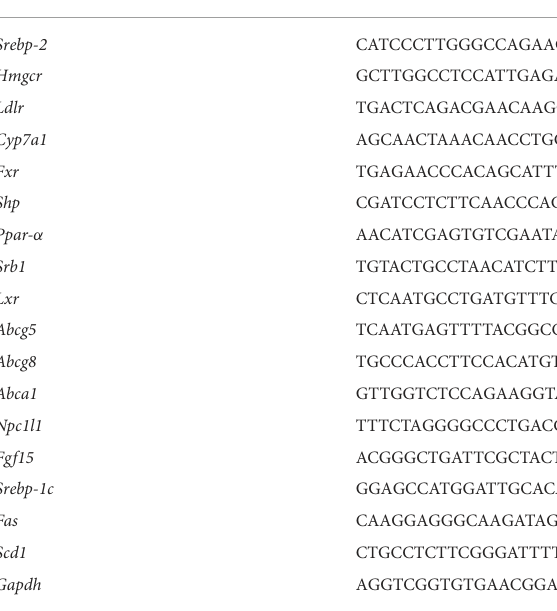
TABLE 1 Primer sequence for real-time quantitative PCR (RT-qPCR). Gene Forward primer (5 ′ –3 ′